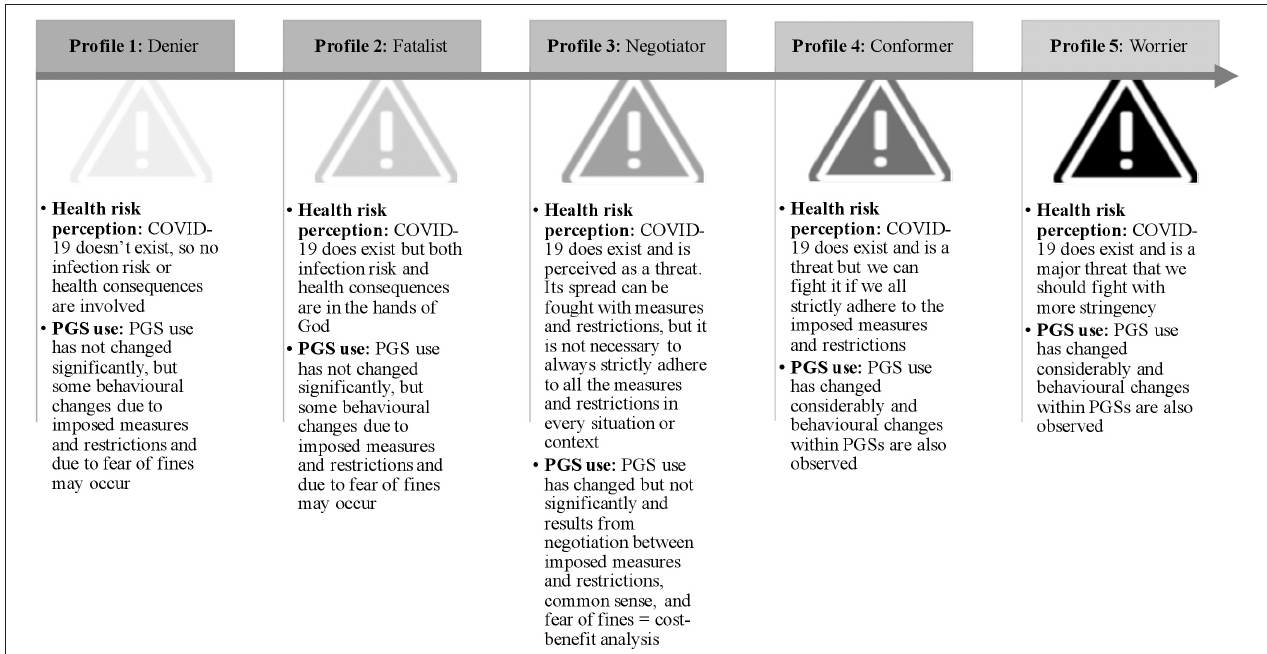
FIGURE 1 | Five different health risk perception profiles in relation to